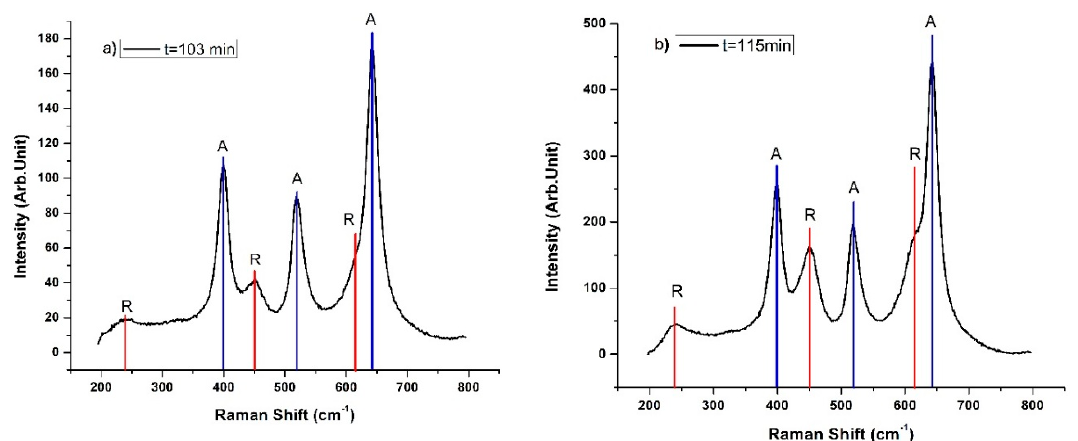
Figure 3. Raman spectra for samples annealed at 475 °C for ( a ) 103 min and ( b ) 115 min.